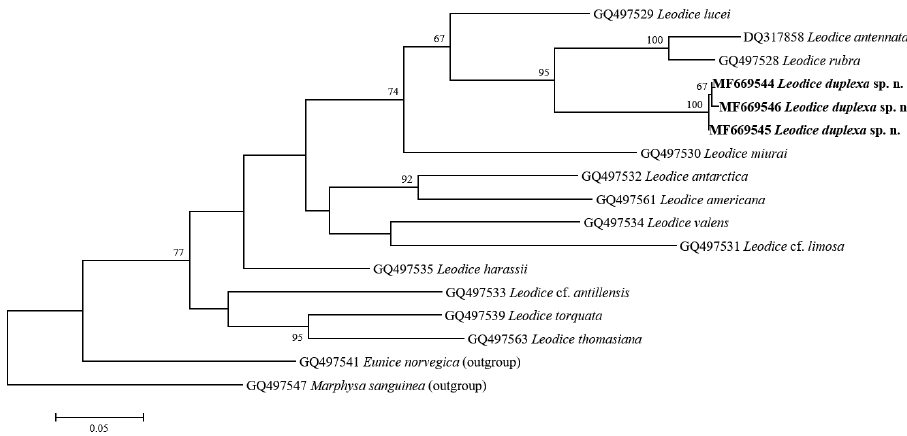
Figure 3. Maximum likelihood tree showing phylogenetic relationship based on COI sequences of 13 Leodice species with two outgroup taxa ( Eunice norvegica and Marphysa sanguinea